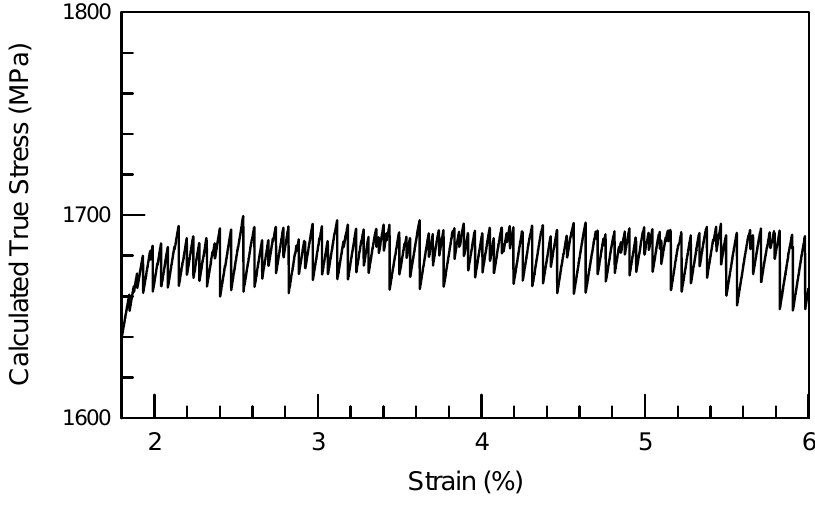
Figure 2. A part of the true stress-strain diagram of Zr room